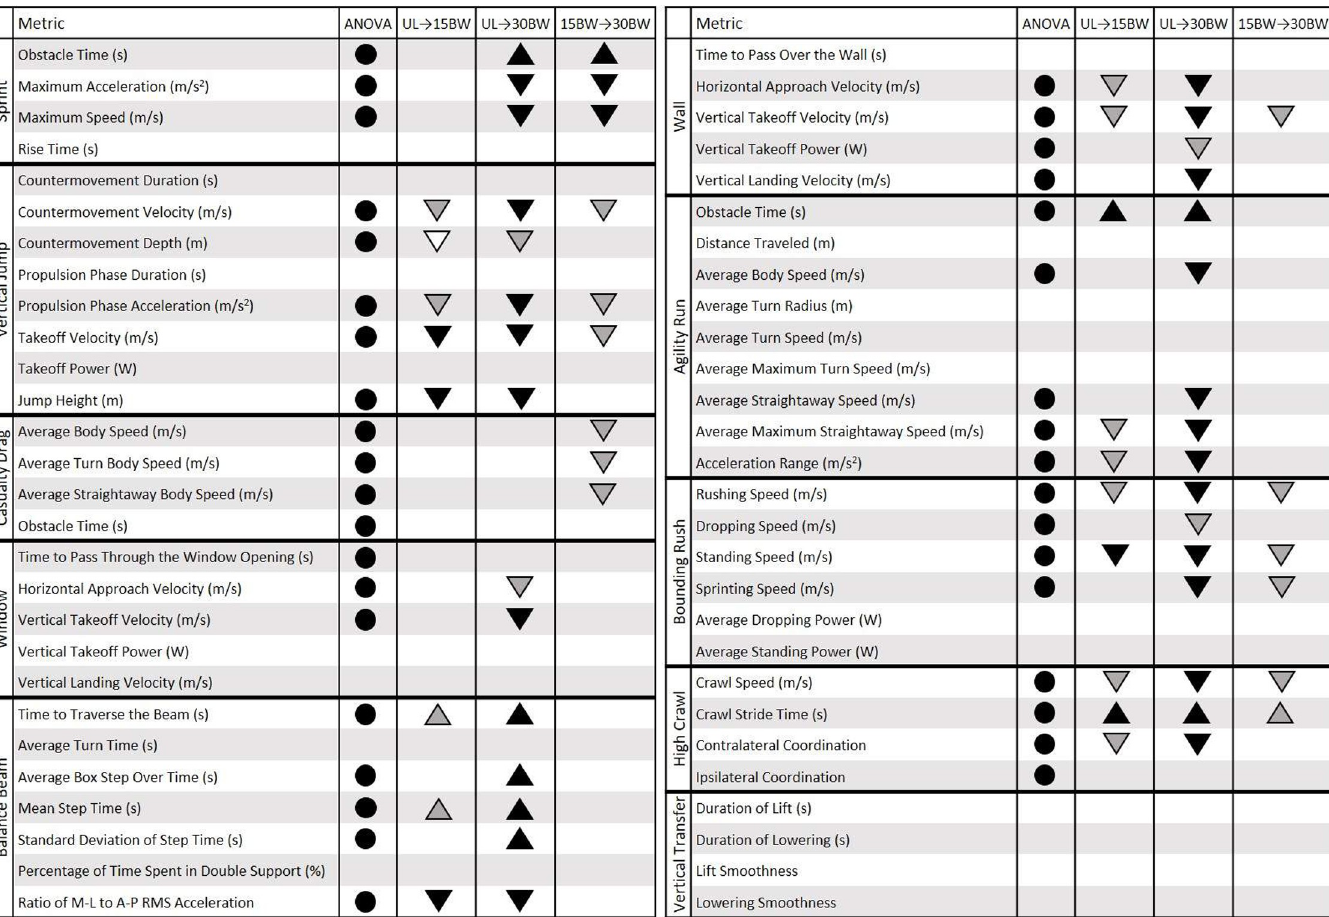
PLOS ONE | https://doi.org/10.1371/journal.pone.0214008 March 21,